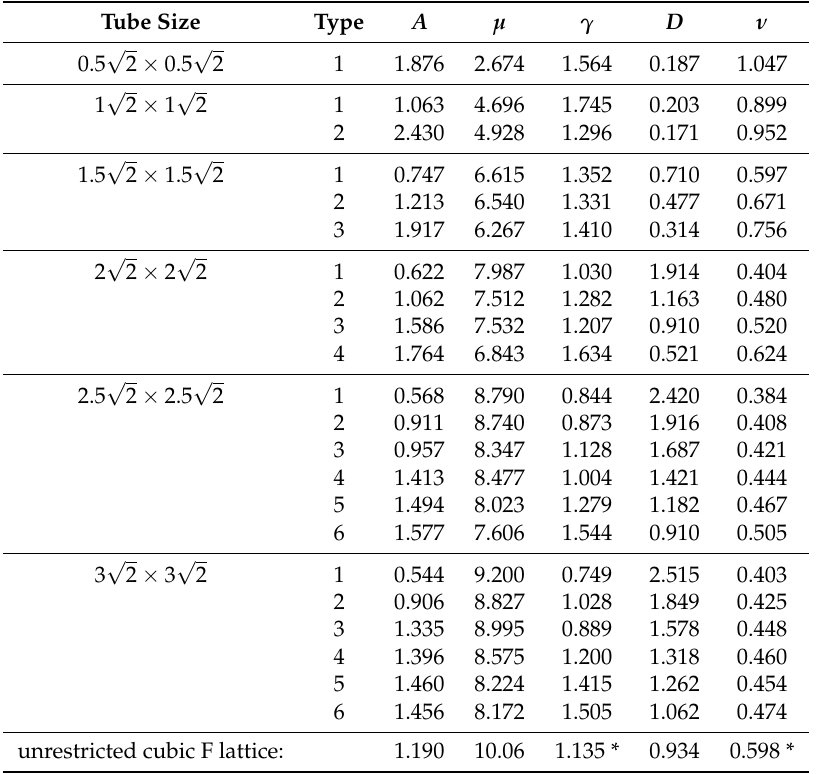
Table 2. Calculated coefficients in scaling laws (1) and (2) for FCC lattice restricted to a tube oriented along [ 100 ] . Universal exponents for unrestricted SAWs are marked with an asterisk